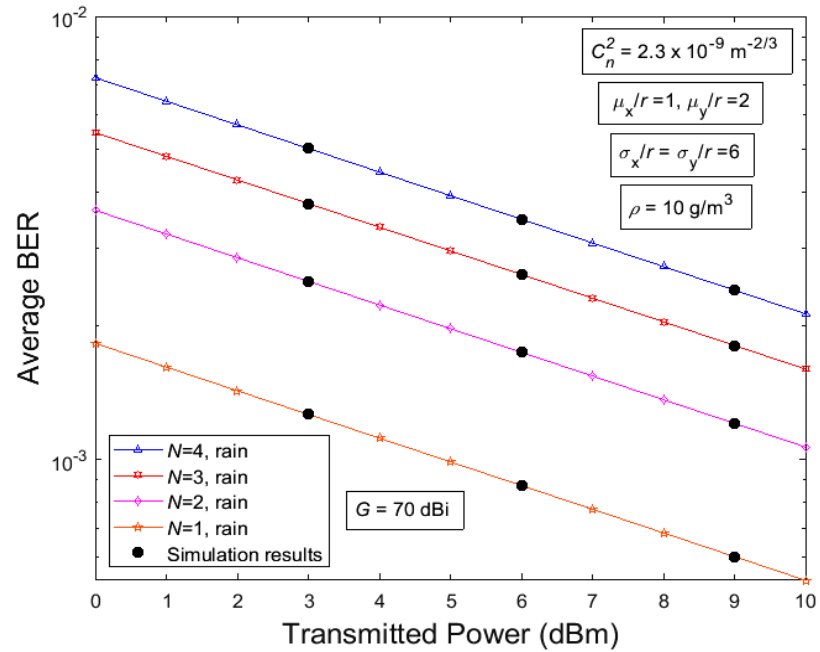
Figure 5. ABER vs. transmitted power for single-hop and multiple-hop THz link configurations under strong turbulence, rain, high water vapor concentration and strong NZB pointing errors.